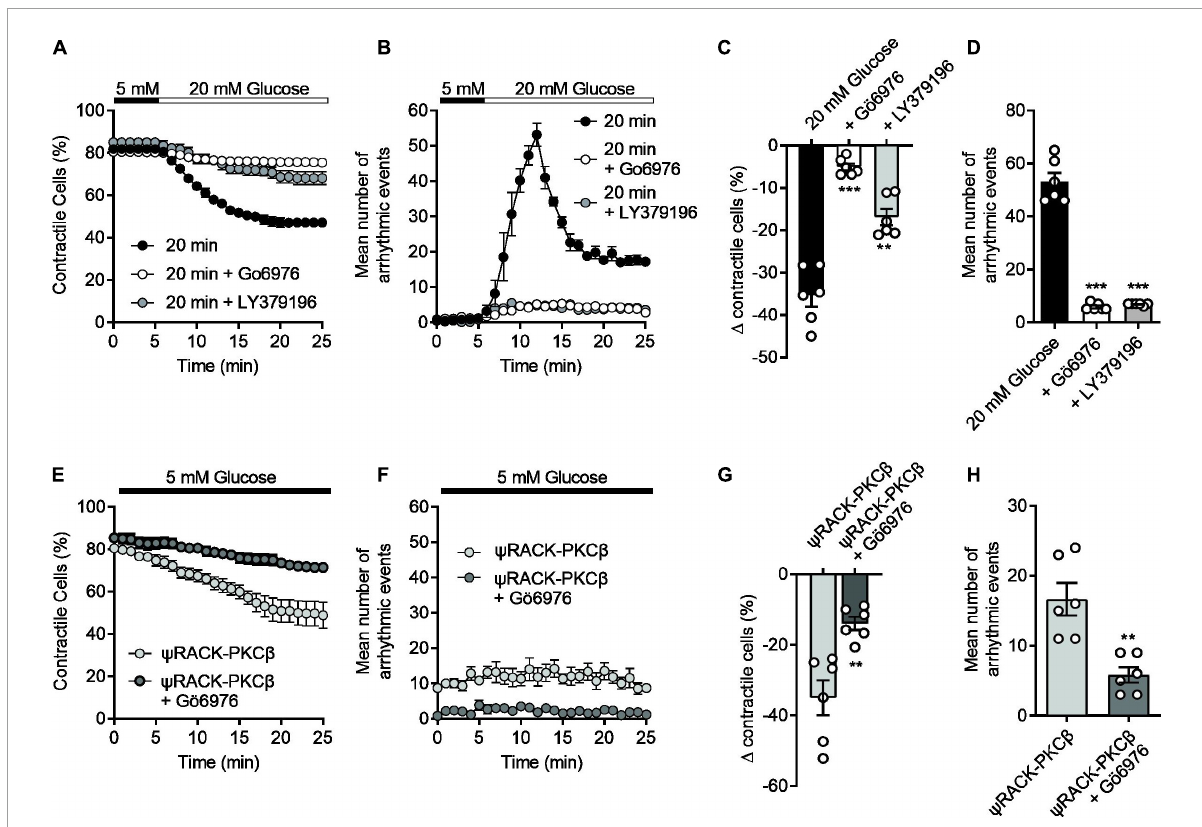
FIGURE6 The high glucose-induced disruption of contractile function in isolated cardiomyocytes can be reversed with selective PKC α / β inhibition and mimicked with a PKC β activator. (A) Time course showing the loss of contractile cardiomyocytes over a 20 min exposure to 20 mM glucose in the absence (black circles) and presence (white circles, Gö6976, grey circles, LY379196) of PKC α / β inhibitors. (B) Time course showing the number of contractions outside of the 1 Hz EFS in the cardiomyocytes recorded in panel (A) . (C) The mean change in contractile cells at the end of the protocol and (D) the mean peak number of arrhythmic evens in each condition (*** P < 0.001, ** P < 0.01, One Way ANOVA with Holm-Sidak post-test, n = 6 experiments from six animals, > 123 cells for each group). (E) Time course showing the loss of contractile function in cardiomyocytes pre-incubated for 15 min with Tat- ψ RACK-PKC β -activating peptide in the absence (light grey) and presence (dark grey) Gö6976 in 5 mM glucose. (F) Time course showing the number of contractions outside of the 1 Hz EFS in the cardiomyocytes recorded in panel (E) . (G) The mean change in contractile cells at the end of the protocol and (H) the mean peak number of arrhythmic evens in each condition [** P < 0.0026 (G), ** P < 0.0018 (H) , unpaired t -test, n = 6 experiments from six animals, > 105 cells for each